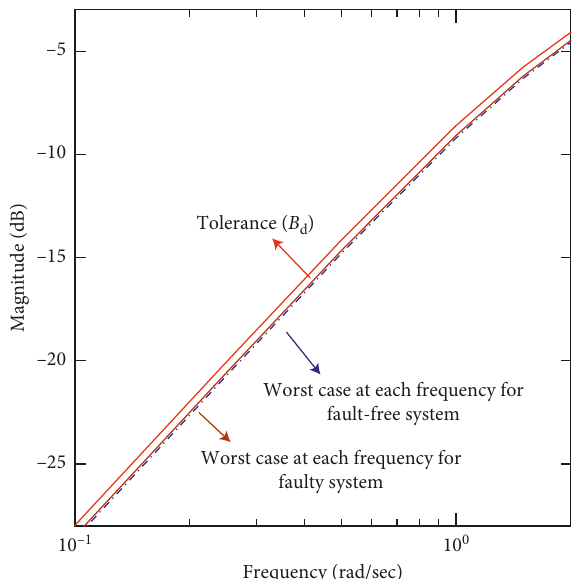
Figure 5: Frequency-domain validation of the robust output disturbance rejection specification.